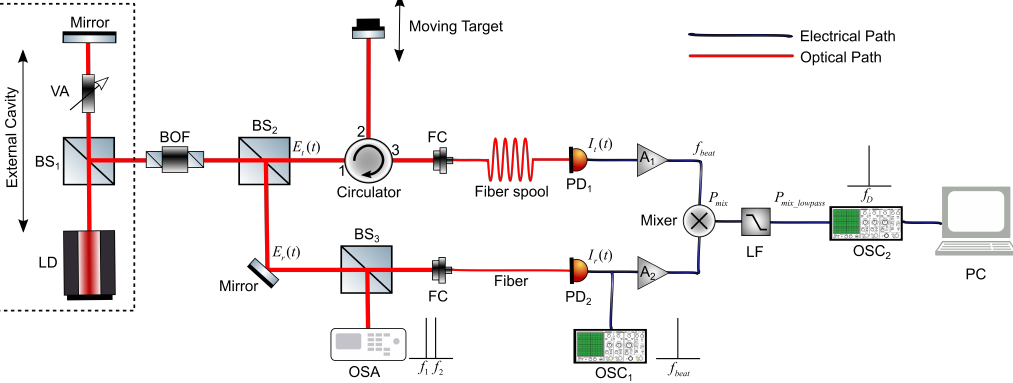
Figure 6. Experimental setup of Dual-frequency Doppler LiDAR (DFDL) system. LD, single-mode laser diode; MFS, microwave frequency synthesizer; BS, beam splitter; VA, variable attenuator; BOF, bandpass optical filter; FC, fiber coupler; Circulator; Fiber and Fiber spool; PD 1 and PD 2 , high-speed photodiodes; A 1 and A 2 , microwave amplifiers; Mixer, microwave mixer; OSC 1 and OSC 2 , digital oscilloscopes; OSA, optical spectrum analyzer; LF, lowpass filter; PC,